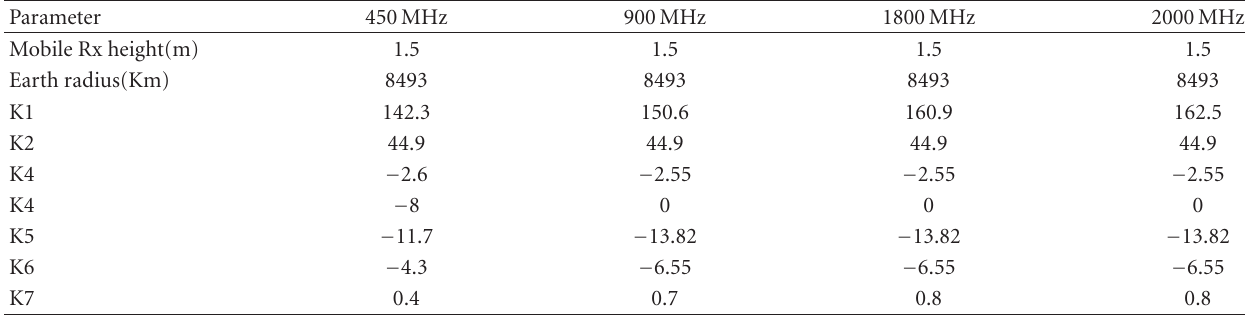
Table 3: Parameters of the Aircom tool at various frequencies.